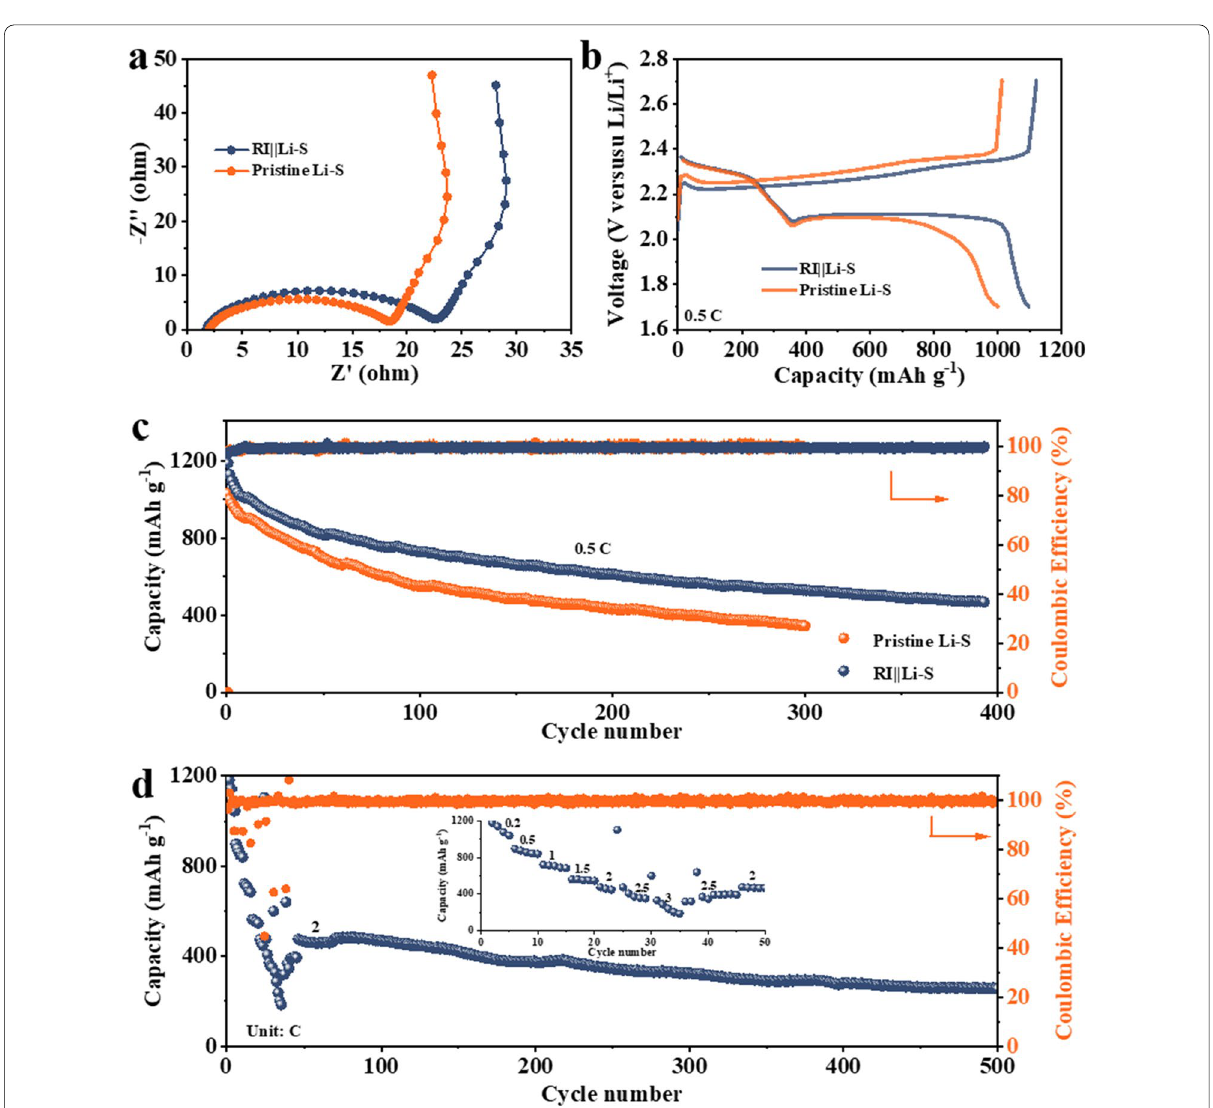
Fig. 4 a ZK results. b Two-plateau charge/discharge profile of the pristine Li and RI||Li at a current rate of 0.5 C. c The comparison of cycling performance and Coulombic efficiency with pristine Li and RI||Li at 0.5 C. d Rate and long cycle performance of